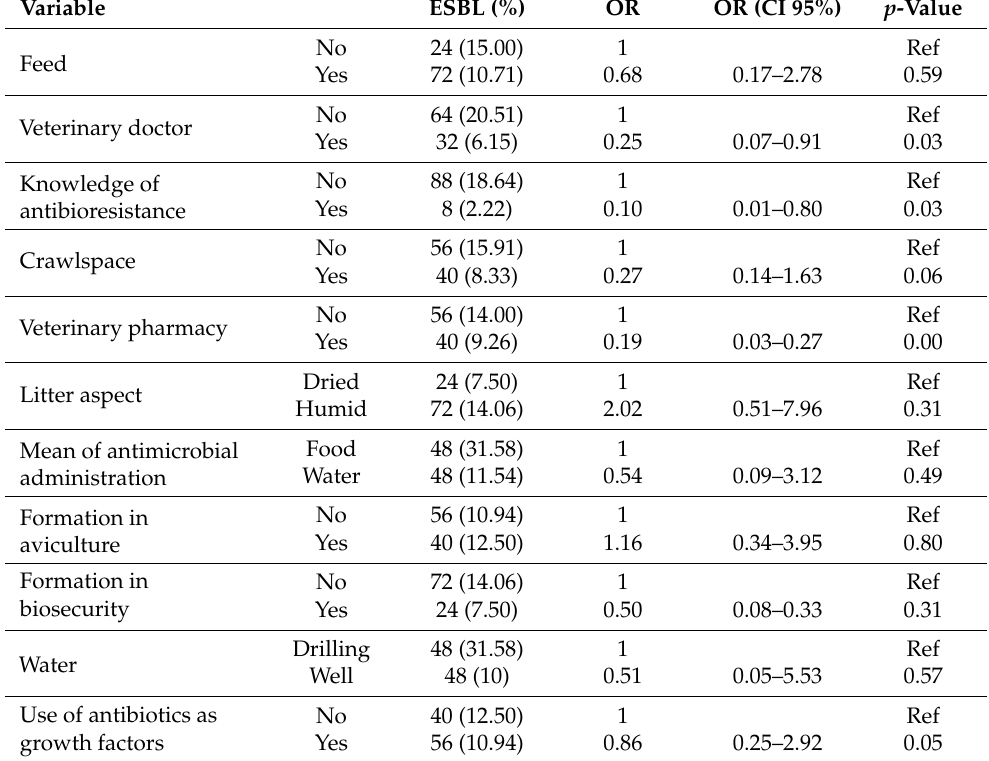
Table 4. Distribution of associated factors using univariate logistic regression analysis.